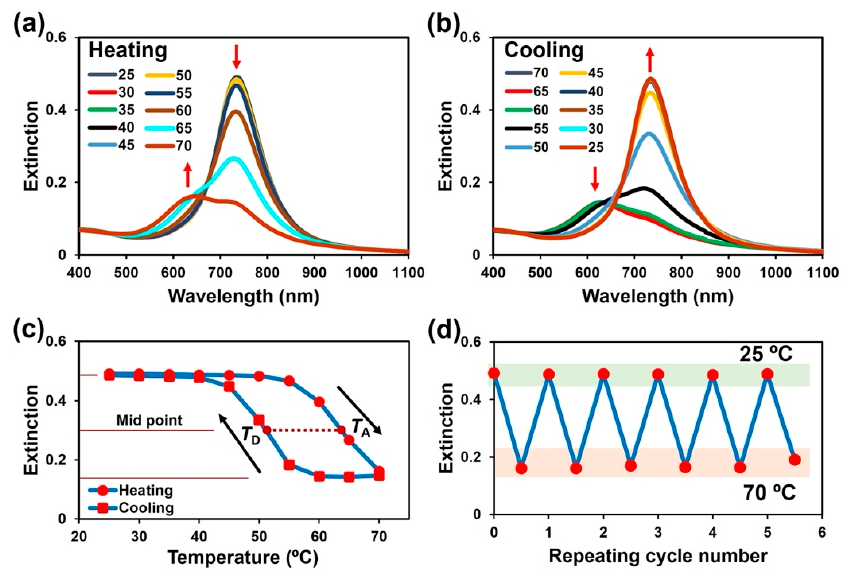
Figure 3. Thermo-responsive assembly of 60-AuND-(97:3): ( a ) the extinction spectra of 60-AuND- (97:3) upon heating from 25 to 70 ◦ C and ( b ) upon cooling from 70 to 25 ◦ C; ( c ) the extinction values at 715 nm against temperature changes; ( d ) the reversible changes in extinction values between 25 and 70 ◦ C. The red arrows in ( a , b ) indicate the plasmon peak